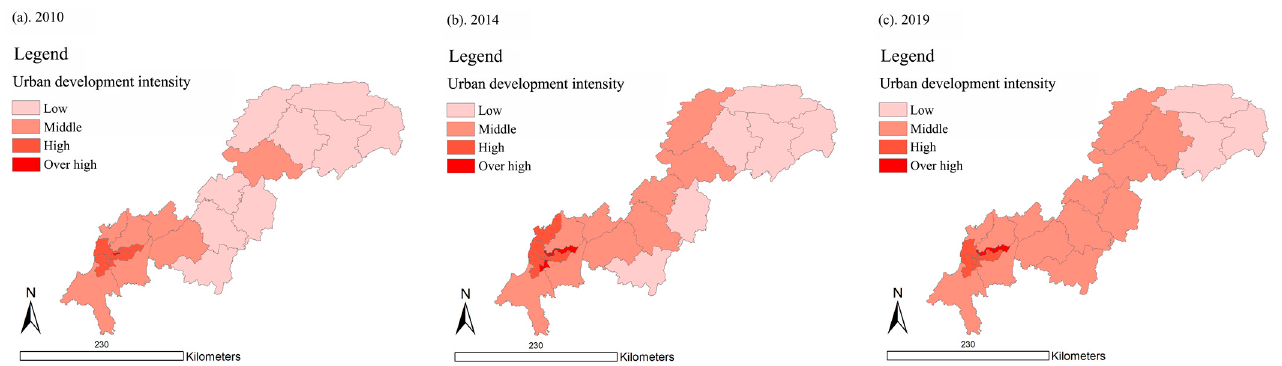
Figure 5. Spatial distribution of UDI in the Three Gorges Reservoir Area (Chongqing section) in year 2010, 2014, and 2019 (presented in subfigure a – c , respectively). Sources: Calculation results of UDI in the Three Gorges Reservoir Area (Chongqing section).